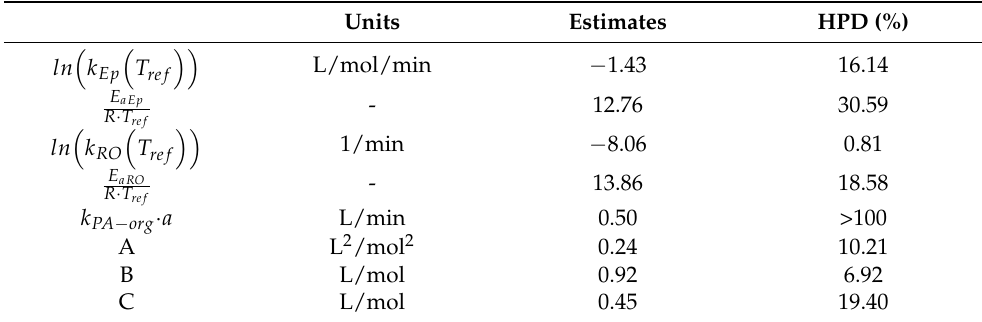
Table 5. Estimated parameters and their credible intervals for the epoxidation of cottonseed oil at T ref = 343.15 K.